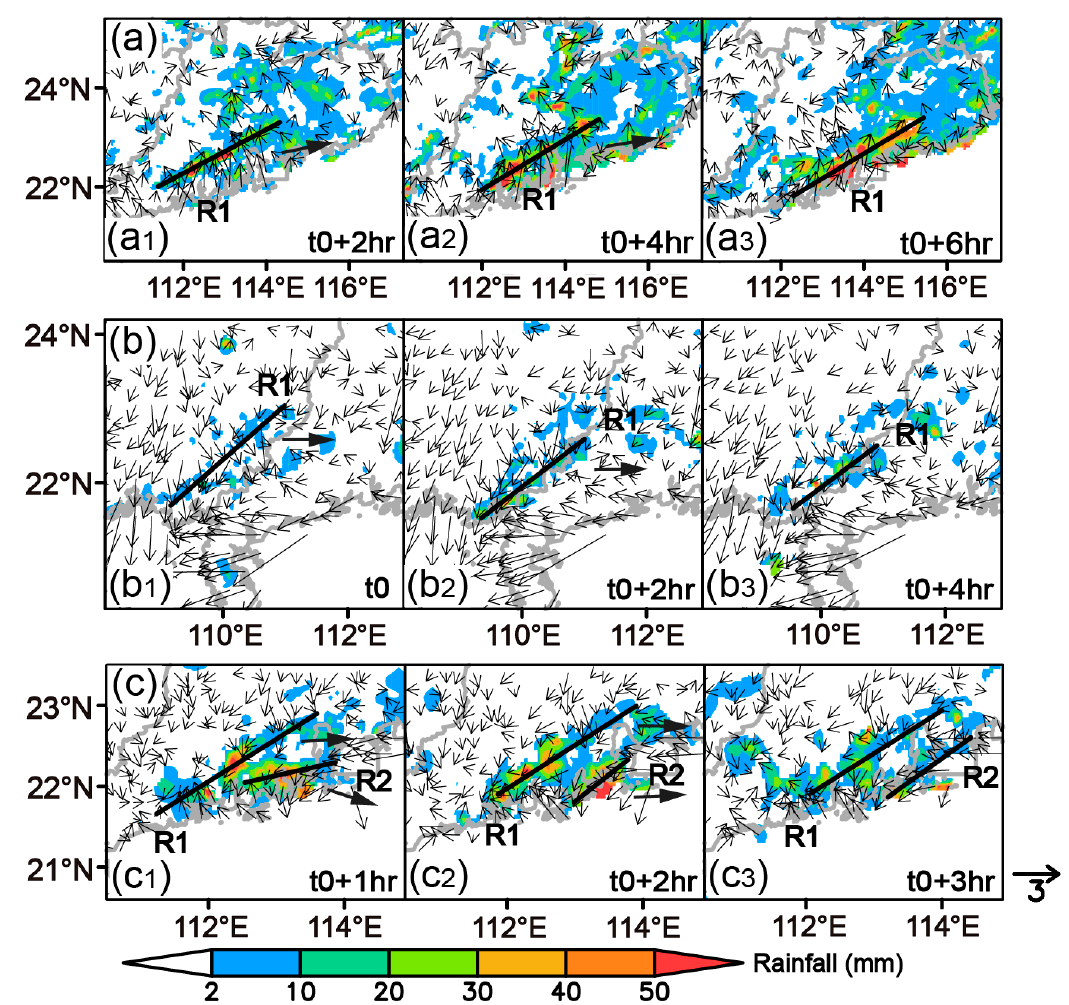
Figure 14. Evolution of composite cumulative rainfall distributions (color-shaded; units: mm) and near-surface wind vectors (units: m s − 1 ) under ( a , a 1 – a 3 ) the vertical wind profile of WP1-3 in the SWLLJ situation and ( b , b 1 – b 3 and c , c 1 – c 3 ) the vertical wind profile of WP2 in the ACR situation. The lines (“R1” and “R2”) and arrows indicate rainfall belts and their approximate motion directions, respectively. “t0” and “t0 + x h” indicate the initial time of rainfall and “x” hours after. “ a 1 – a 3 ” to “ c 1 – c 3 ” show the evolution of the rainfall distributions and near-surface wind vectors near the coastal areas of Guangdong Province, the boundary between Guangxi and Guangdong provinces, and west Guangdong Province.